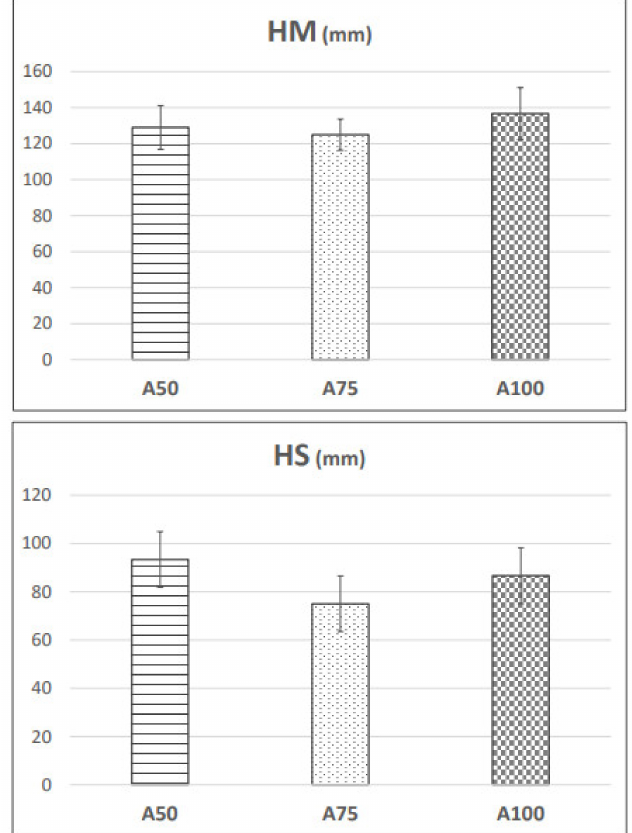
Figure 3. Foam properties of sparkling wines after 9 months of aging on lees from the STAGE 3 (A50, A75, A100) measured by the Mosalux method. HM: Foam maximum height; HS: Foam stability height.